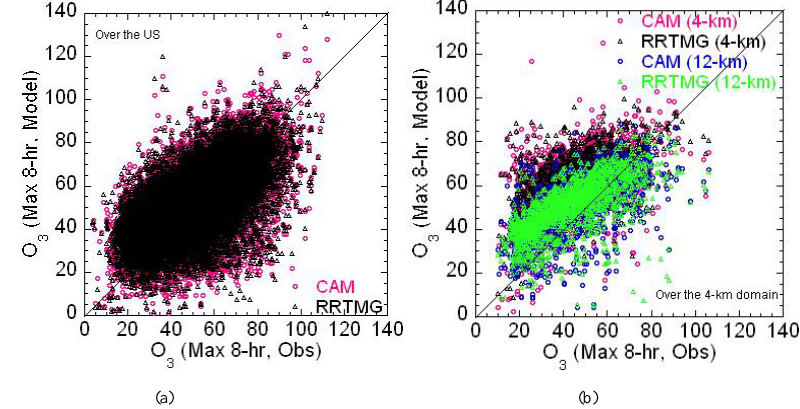
Figure 4. Scatter plots of the modeled (CAM (WRF-CMAQ/CAM) and RRTMG (WRF-CMAQ/RRTMG)) and observed 8-hr O3 concentrations (ppbv) at the AIRNow monitoring sites (a) over the continental U.S.(12-km resolution model grid); (b) the results over eastern Texas from the simulations at 4-km and the 12-km resolution model grids for August of 2006.